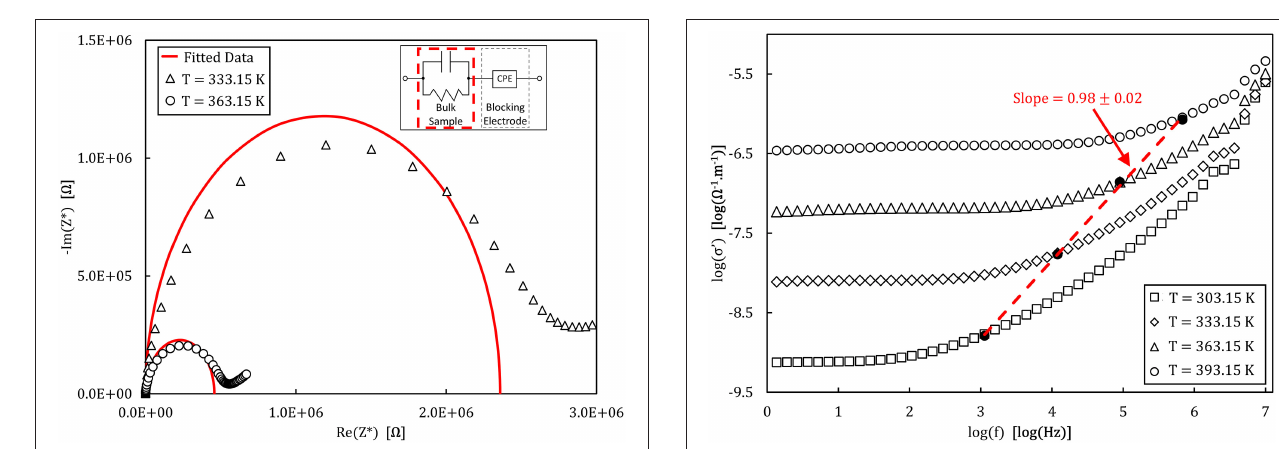
FIGURE 8 | Bode plot of the real part of the complex conductivity measured for the NaPO 3 glass at different temperatures. The empty symbols show the experimental data while the filled symbols represent the onset of AC = 2 σ dc . The dashed line represents the linear fit of the f H conductivity σ * onset frequencies. (cid:0) (cid:1)